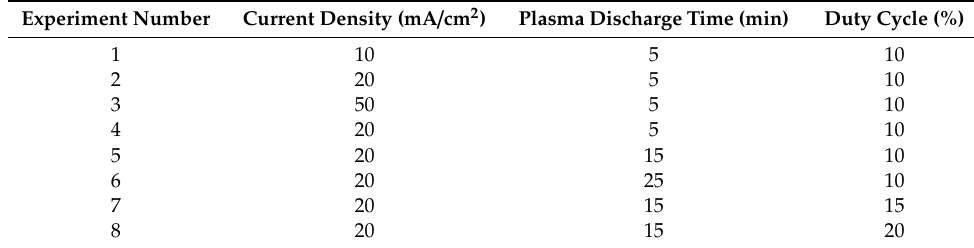
Table 5. Parameters of MAO